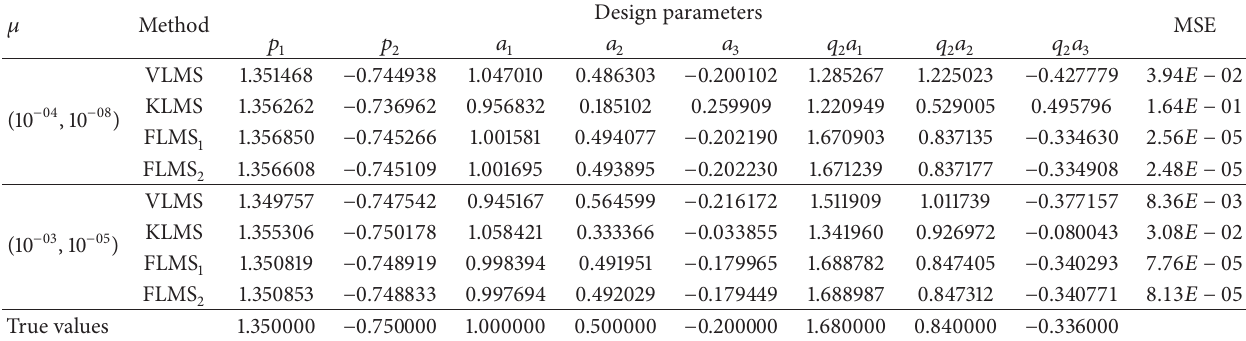
Table 7: Comparison of proposed results against true values of INCAR model for 10dB SNR.